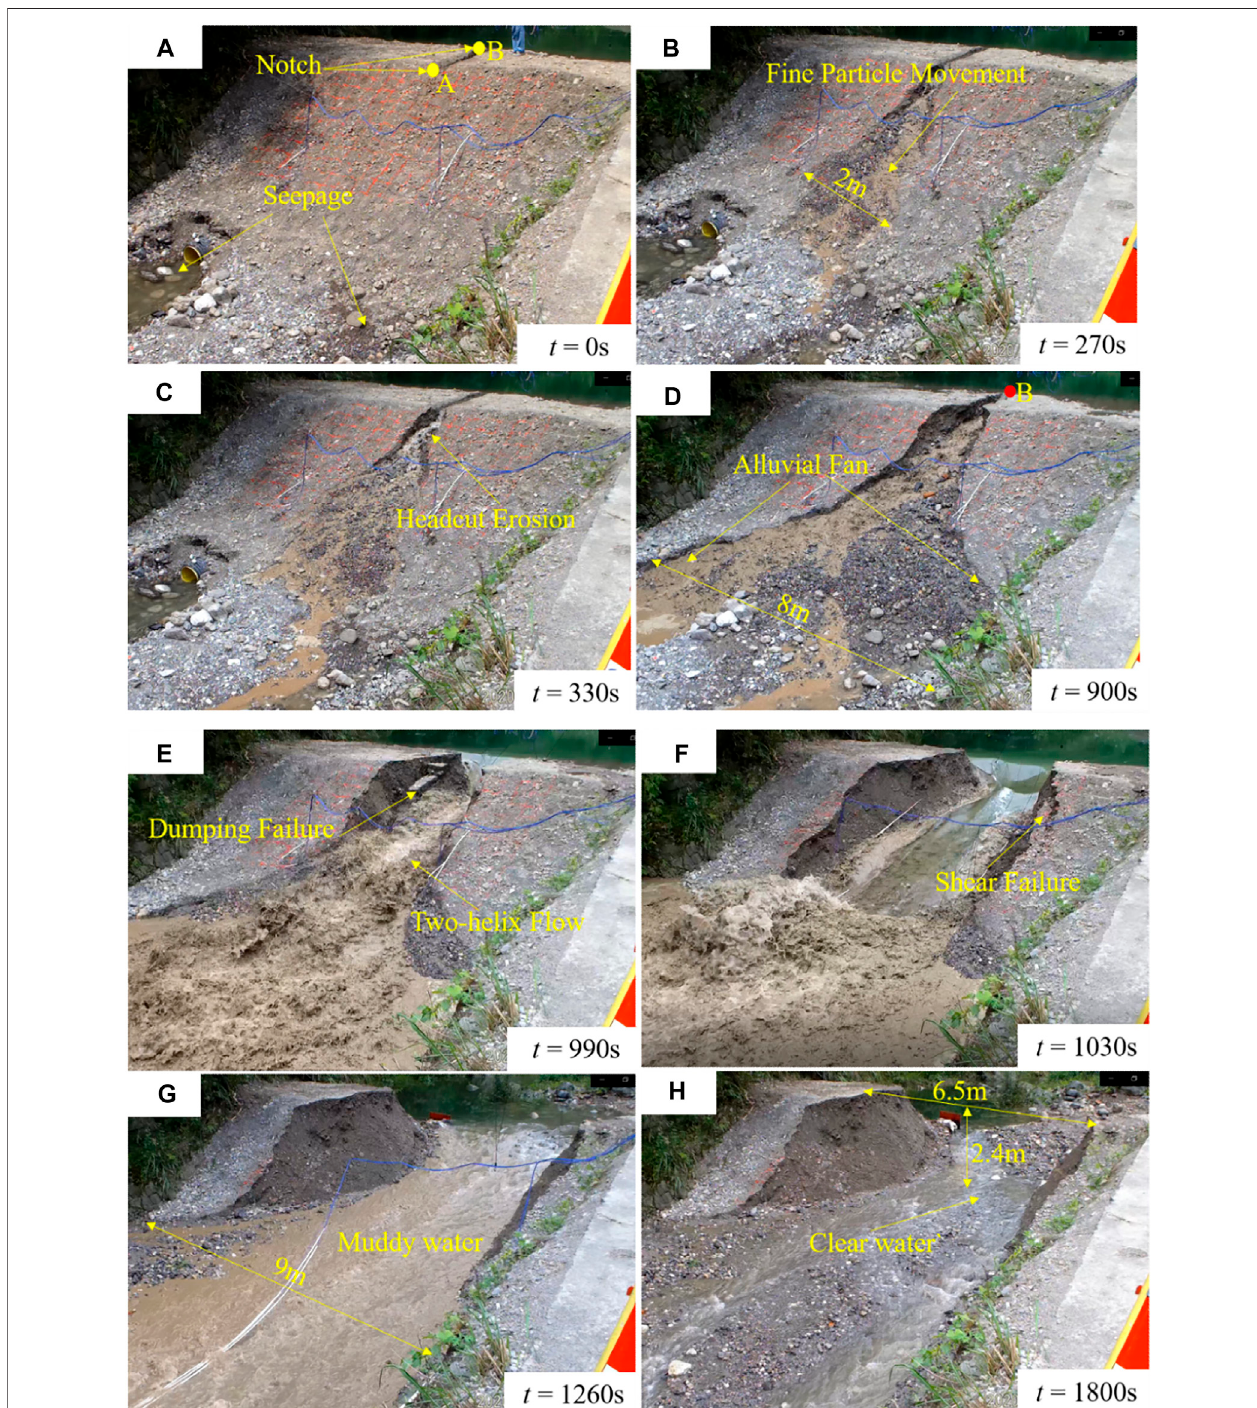
FIGURE7| Imagesofdamfailureprocessatdifferenttime: (A,B) themainfeaturesoftheStageI, (C,D) themainfeaturesoftheStageII, (E – H) themainfeaturesof the Stage III.